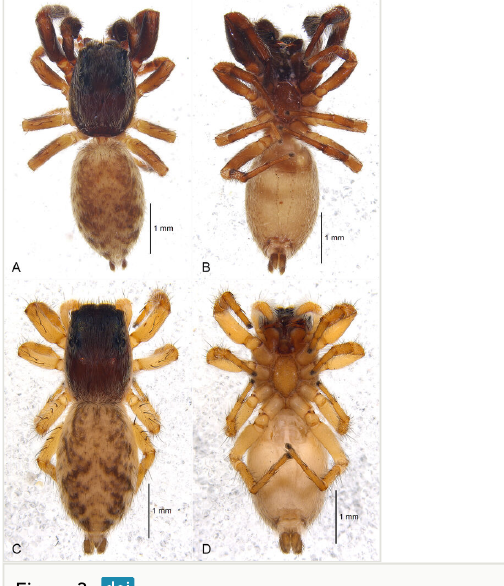
Figure 2. Tasa koreanus (Weso ł owska, 1981): A male habitus, dorsal view; B same, ventral view; C female habitus, dorsal view; D same, ventral view.